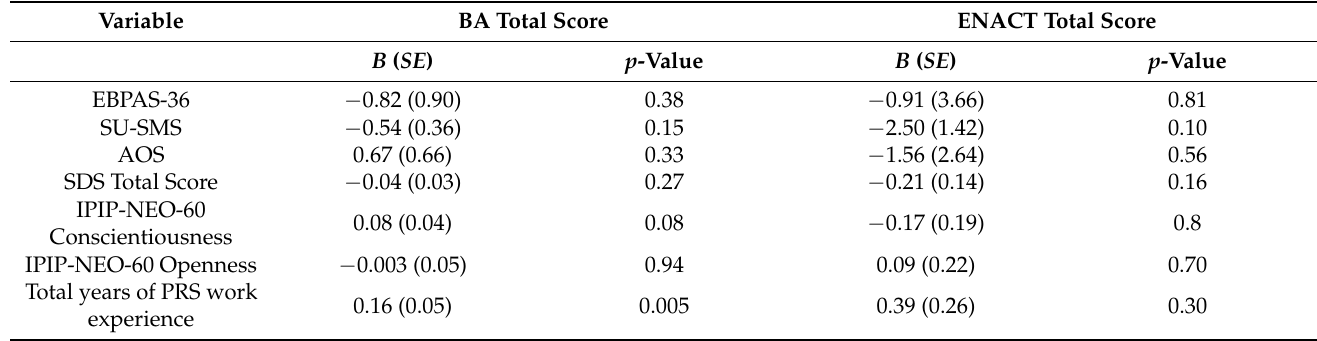
Table 4. Predictors of change in BA and clinical competency